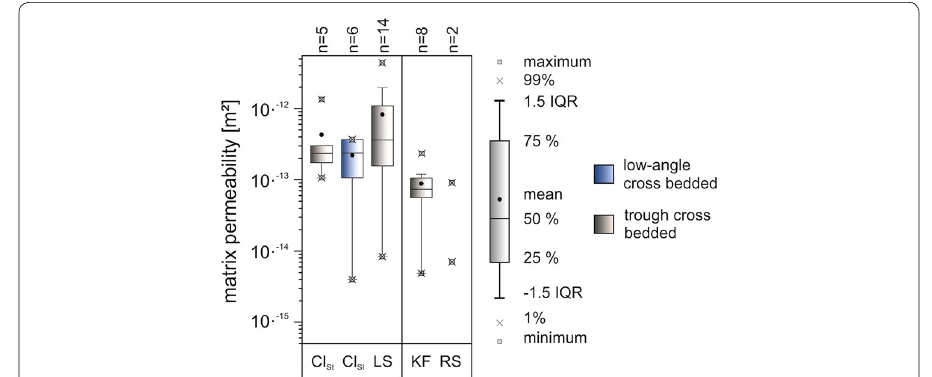
Fig. 9 Box–whisker plot of the calculated matrix permeabilities. Outcrops ordered according to their loca‑ tion, from west to east, and colour coded according to fabric